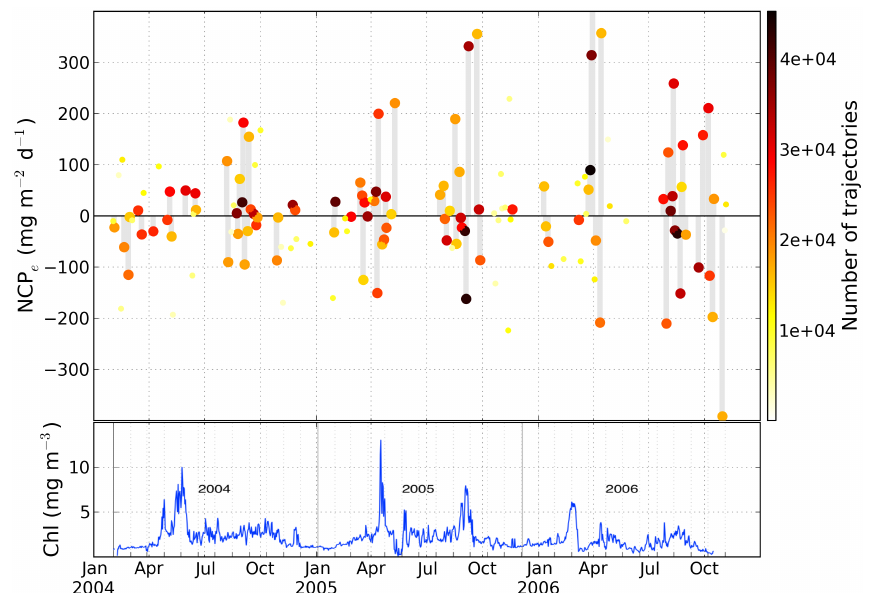
Fig. 5. The upper panel shows the region-wide median NCP e values calculated from a number of satellite image pairs for 2004–2006. The color of each point indicates the number of trajectories used for creating the estimate. Values based on more than 50% of potentially available trajectories are denoted by grey bars. Points without a grey bar are based on satellite images with partial coverage of the Gulf, and therefore they tend to represent a local region of the Gulf, rather than the full area. The lower panel shows the median value of the surface chlorophyll recorded by the four GoMOOS (Pettigrew et al., 2008) buoys A, B, E, and I. Large NCP e events diagnosed from the satellite-model analysis are followed by an increase in surface Chl recorded by buoys. are much larger than the mean itself.